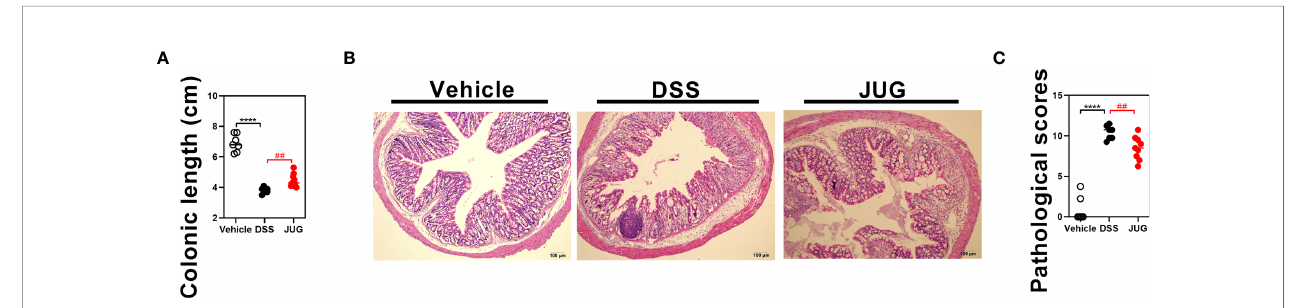
FIGURE 2 | Colon length and pathological scores of mice. (A) Colon length of each mouse in each group. (B) Representative H&E staining images of the colon (×100) and (C) pathological scores from the colonic sections in each group. **** P < 0.0001, ## P <